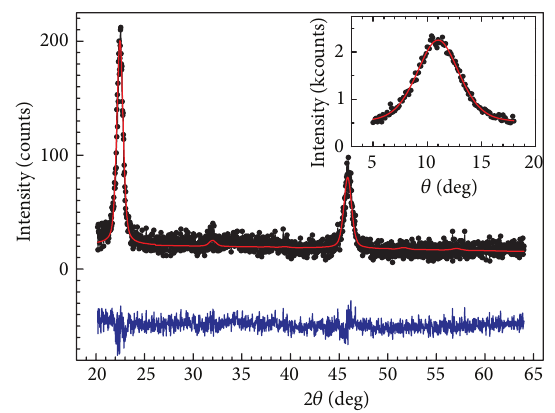
Figure 4: Rietveld fit of an XRD pattern of bismuth ferrite films deposited Ar gas pressure 𝑝 = 2 mTorr at a distance 𝑑 = 6 󸀠󸀠 and heat-treated at 500 ∘ C. The line at the bottom shows the difference between the theoretical and the experimental line. The inset shows a rocking curve around the (001)